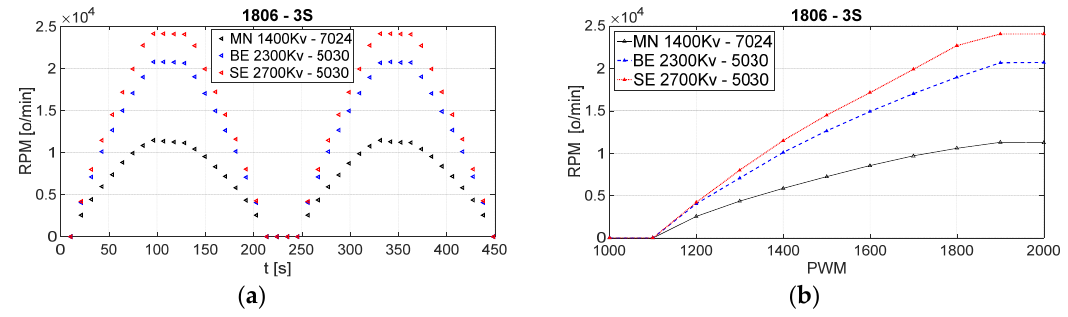
Figure 7. Rotor RPM for setup with 1806 series of BLDC motor: ( a ) raw measurement; ( b ) RPM static maps.